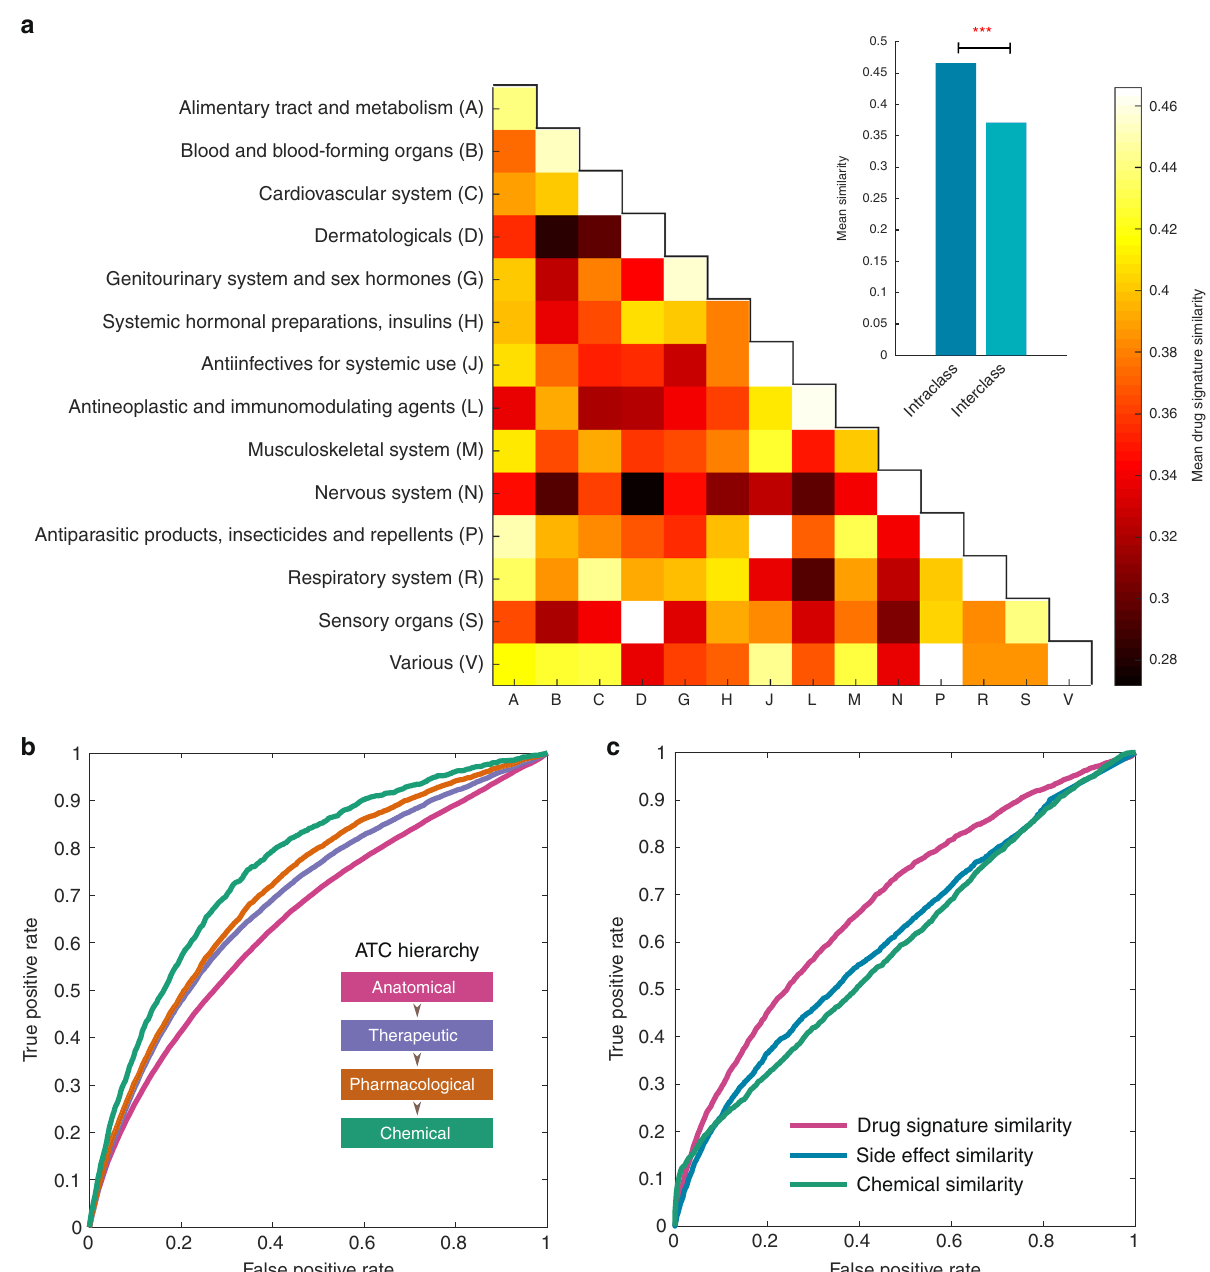
Fig. 5 Drug signatures capture drug clinical and molecular activity. a Heat maps of mean drug signature similarities per anatomical class. Each ( x , y ) tile represents, for each main Anatomical, Therapeutic and Chemical (ATC) drug category, the mean similarity of drug pairs where one drug belongs to category x and the other to category y . The value ranges from 0.27 (Nervous system — dermatological) to 0.55 (Nervous system — nervous system). The colours range between the minimum mean similarity and 0.466, with all values >0.466 (in the diagonal: 0.471 (C), 0.512 (D), 0.55 (N), 0.47 (P), 0.52 (R), 0.475 (V)) set to 0.466. Inset: the average intraclass similarity is signi fi cantly higher than the average inter-class similarity ( t test signi fi cance, P < 2.62 × 10 − 13 . b ROC curve representing the ability of the drug signature similarity to discriminate pairs of drugs that share Anatomical, Therapeutic and Chemical (ATC) category at each of the different levels in the ATC taxonomy. Drug signature similarity was predictive of clinical drug activity at different levels: anatomical class (38,711 pairs share vs 248,950, AUROC = 65.33%), therapeutic subclass (11,960 pairs share vs 275,701, AUROC = 69.51%), pharmacological subclass (5,522 pairs share vs 282,139, AUROC = 71.54%) and chemical subclass (1,736 pairs share vs 285,925 do not, AUROC = 76.05%). c ROC curve representing the ability of the drug signature similarity, side effect similarity and Tanimoto chemical similarity scores to discriminate pairs of drugs that share targets. For 435 drugs in our data set, 2,808 pairs were known to share molecular targets, whereas 91,587 pairs were